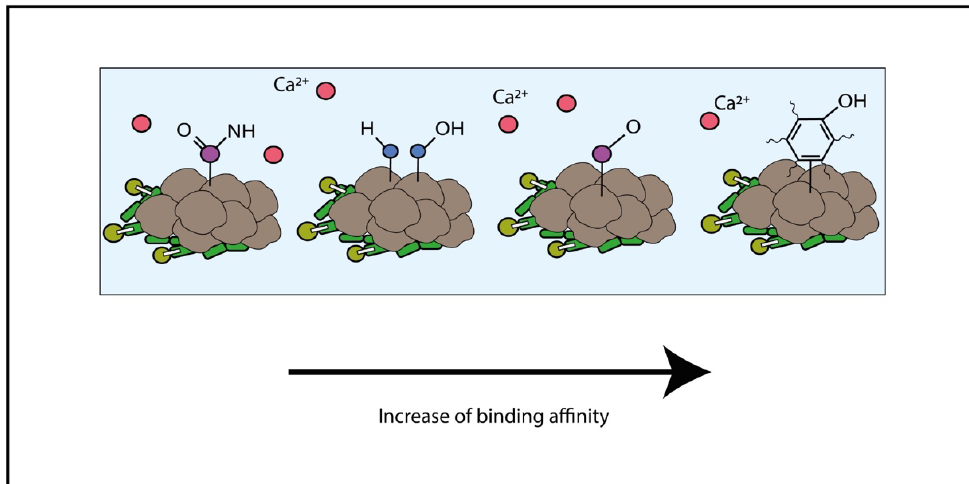
Figure 5. Simplified scheme showing the possibilities of interaction between charged molecules found in EPS and calcium ions, in this case. The red molecules represent any divalent ion, such as Ca 2+ , Mg 2+ , Fe 2+ , Sr 2+ , Mn 2+ or Ba 2+ , found in the solution in the surroundings of the EPS–cells association. As the negative charges of the chemical groups present in the matrix increase their ionic strength, the binding affinity between the ions becomes stronger (from left to right).